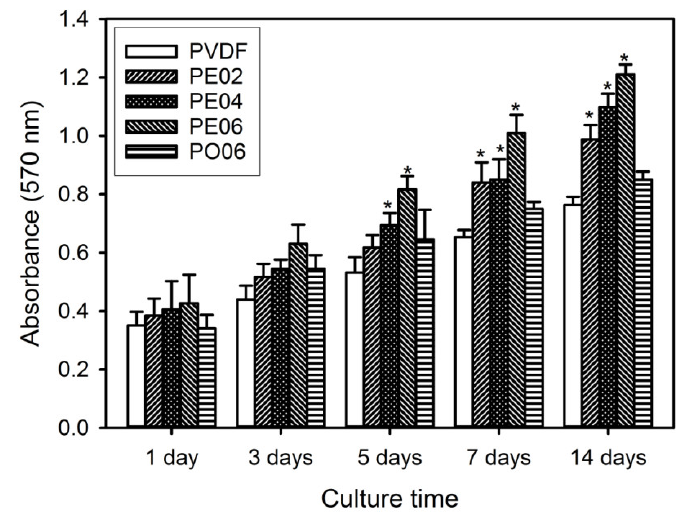
Figure 7. Proliferation behavior of MC3T3-E1 cells cultured on the PVDF composite nanofibers ( n = 6). Significant difference from the pure PVDF nanofiber at each time point was denoted as p * ˂ 0.05.